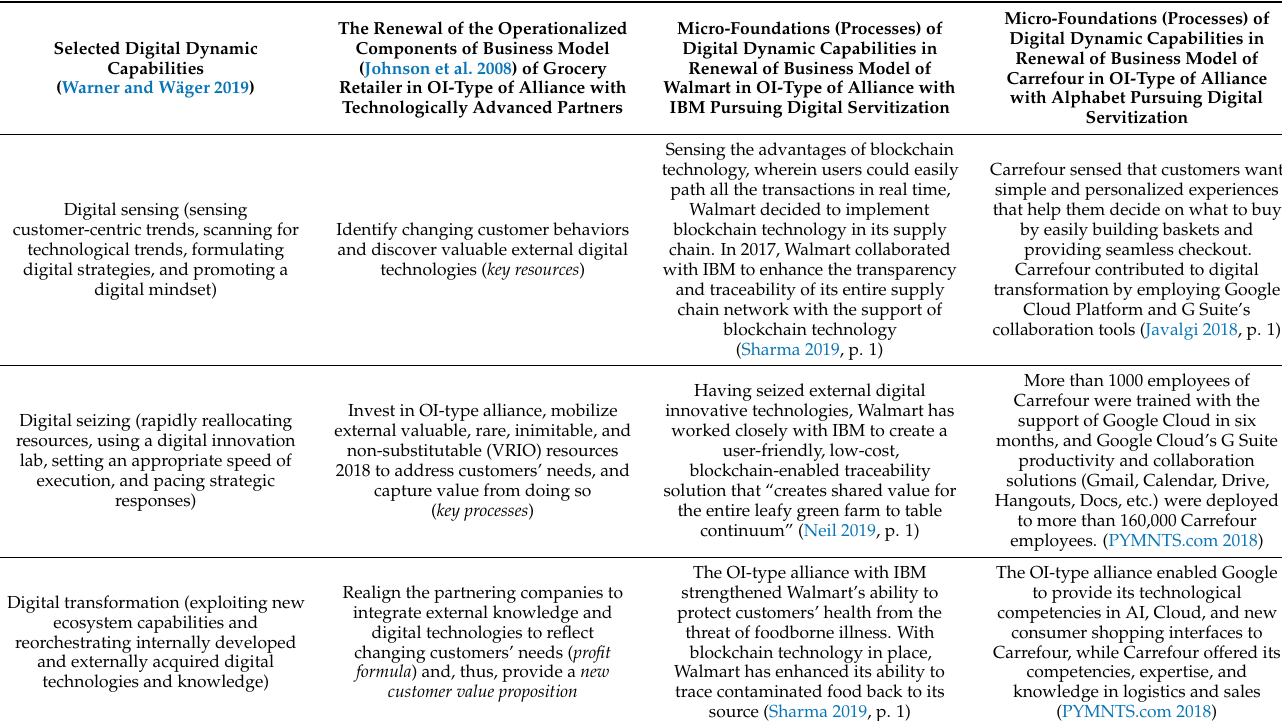
Table 1. Digital dynamic capabilities of Walmart in the OI-type of alliance with IBM and Carrefour in the OI-type alliance with Alphabet for strategic renewal of their business models exerting digital